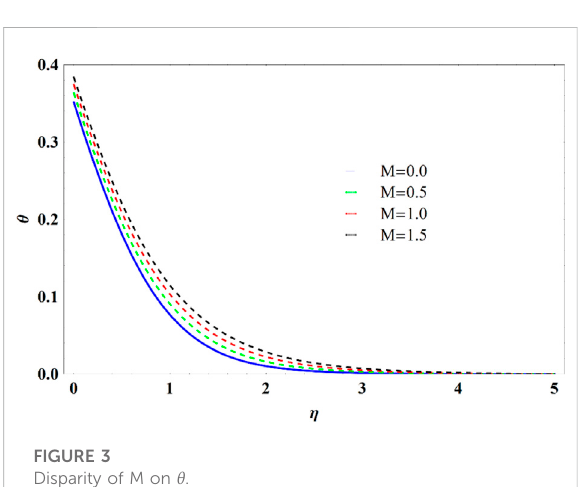
FIGURE 3 Disparity of M on θ